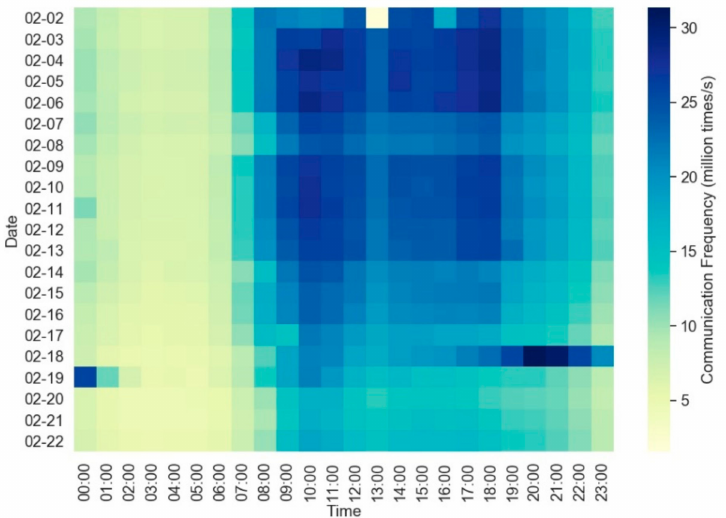
Figure A1. Hourly distribution of CDR number over the whole study